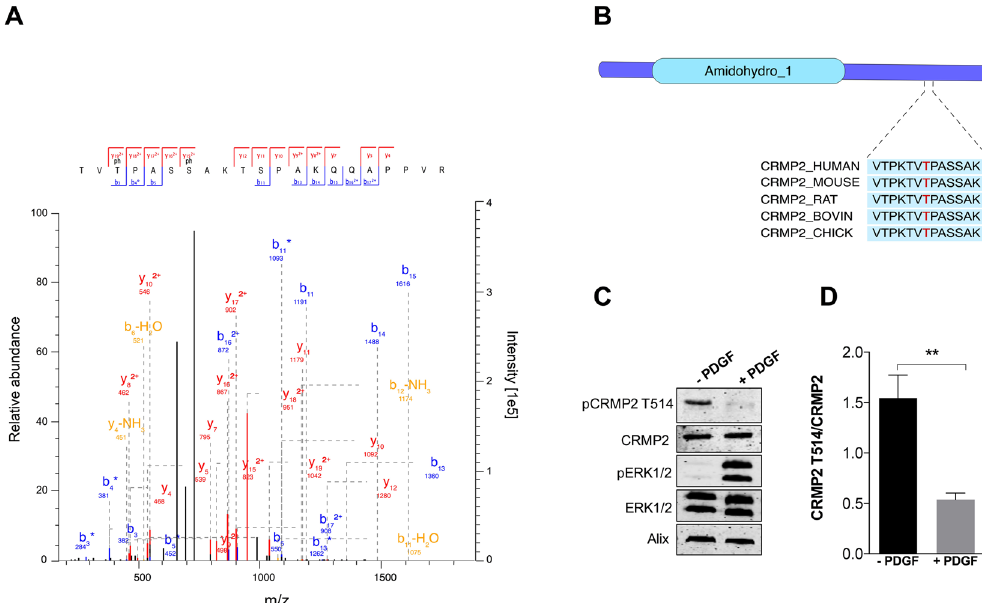
Figure 5. CRMP2 is a novel PDGF-regulated protein. ( A ) Tandem mass spectrum of the CRMP2 T514/S518 phosphopeptide. ( B ) Schematic representation of the domain structure of CRMP2 and the highly conserved amino acid motif containing Thr514. ( C ) MEFs were stimulated with 20 ng/mL PDGF for 7 min. CRMP2, CRMP2 Thr514, ERK1/2, ERK 1/2 Thr202/Tyr204 and Alix in whole cell lysates were analysed by Western blotting. For uncropped images of blots see Supplementary Fig. S2. ( D ) Western blots were quantified and ratios of pCRMP2 to CRMP2 were plotted ( ** P < 0.01).